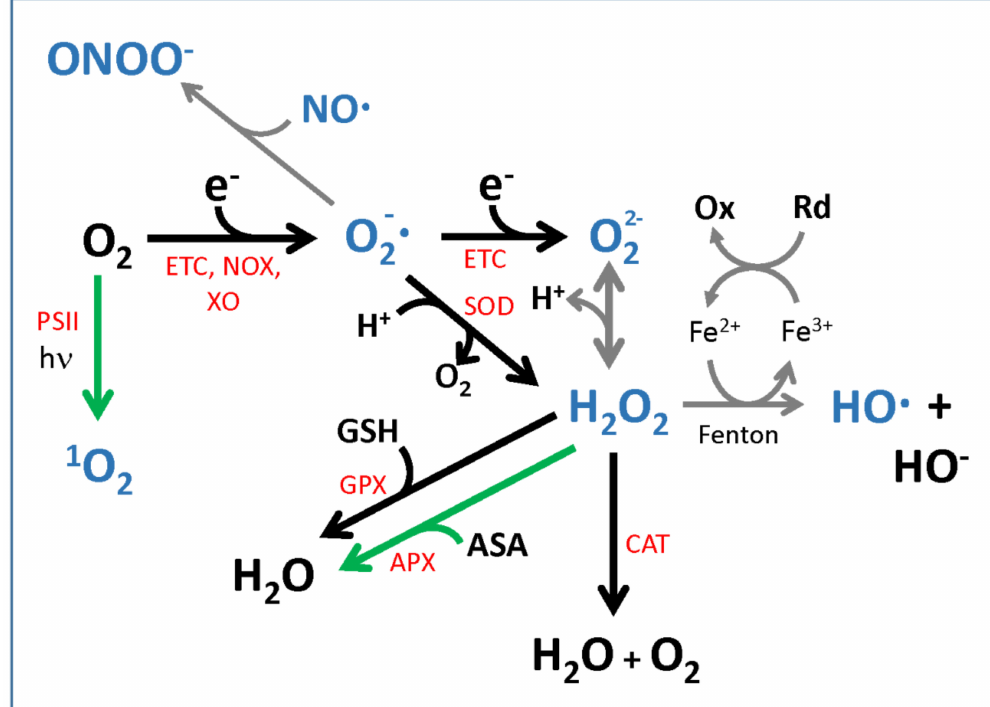
Figure 1. Simplified scheme of cellular (reactive oxygen species/reactive nitrogen species) ROS/RNS metabolism. Reactive species are in blue, and the other reactants in black. Black arrows represent the enzyme-catalyzed reactions, green arrows are essentially plant-specific, grey arrows represent non-enzymatic (spontaneous) reactions, and the enzyme or enzyme complexes are in red. The spontaneous Fenton reaction involves Fe 3+ /Fe 2+ (or Cu 2+ /Cu + , not included) to produce the hydroxyl radical. h ν represents the energy of a photon. NOX, NADPH oxidase (which includes plant respiratory burst oxidase homologue (RBOH); XO, xanthine oxidase; Ox and Rd represent any redox couple able to oxidize Fe 2+ ; other abbreviations are as in the main